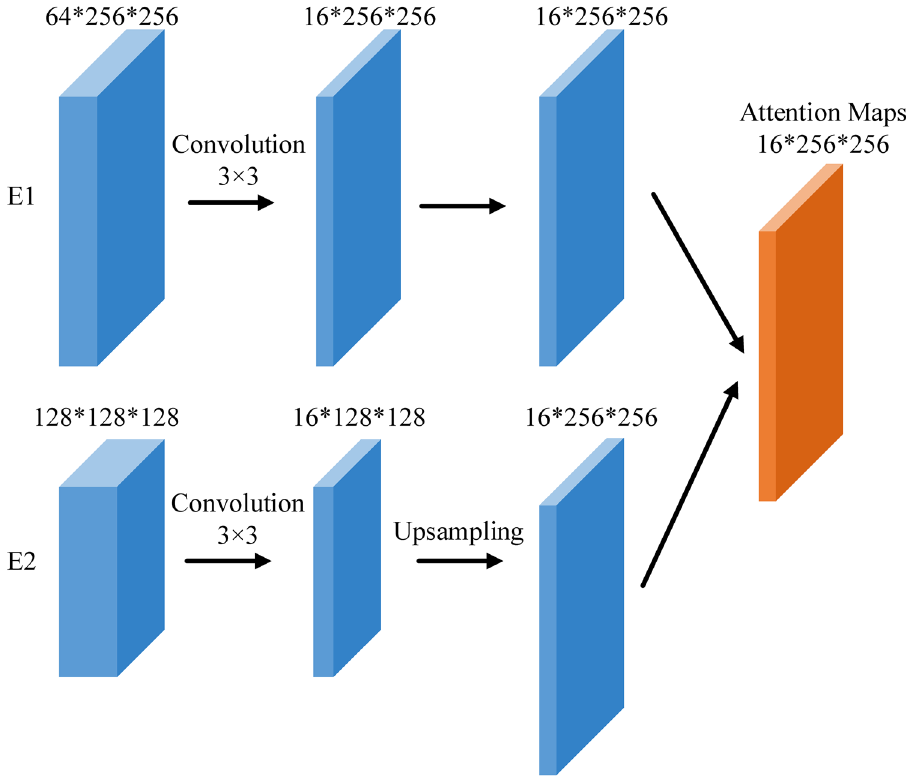
Figure 4. Edge feature